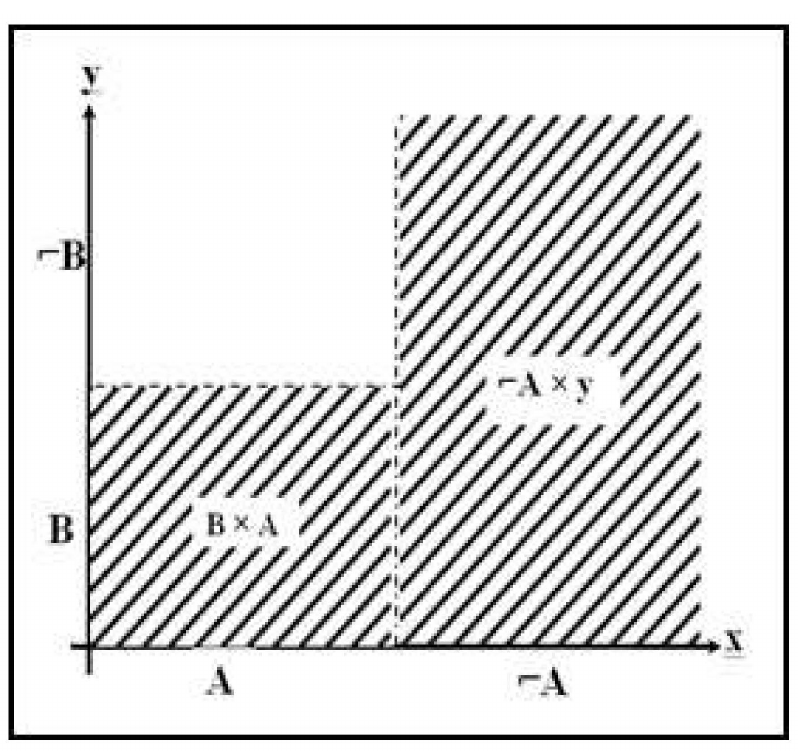
Figure 2. The graphical presentation of the logical rule. The result of Equation (4) represents the production rule of the